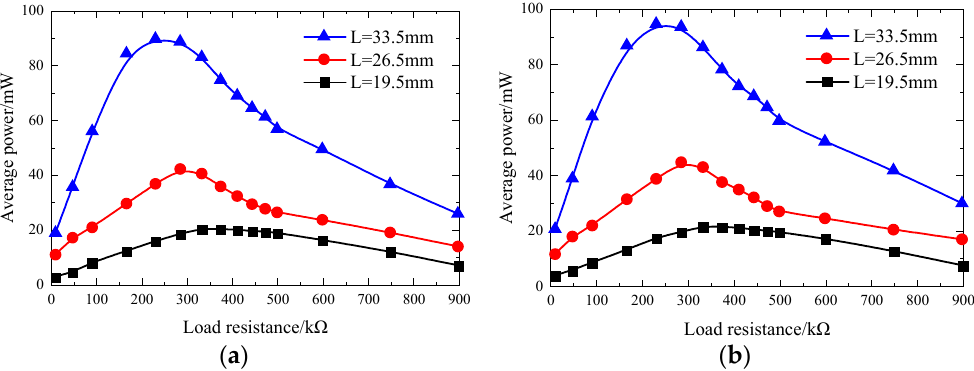
Figure 17. Average powers from unimorph PCSs of #2 piezoelectric brick versus the load resistance and force arm length ( F = 500 N, f = 2 Hz). ( a ) 2#1 PZT4 patch on PCS1; ( b ) 2#3 PZT4 patch on PCS2.